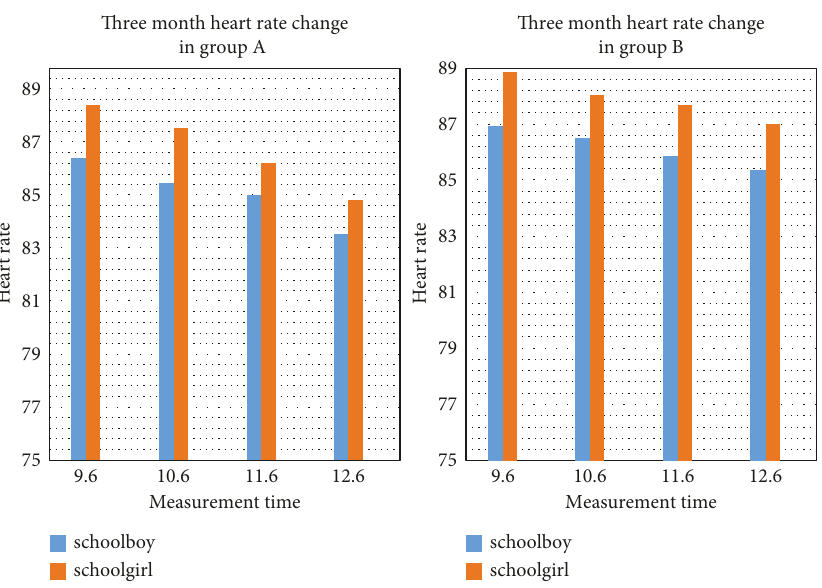
Figure 7: Comparison chart of students’ heart rate